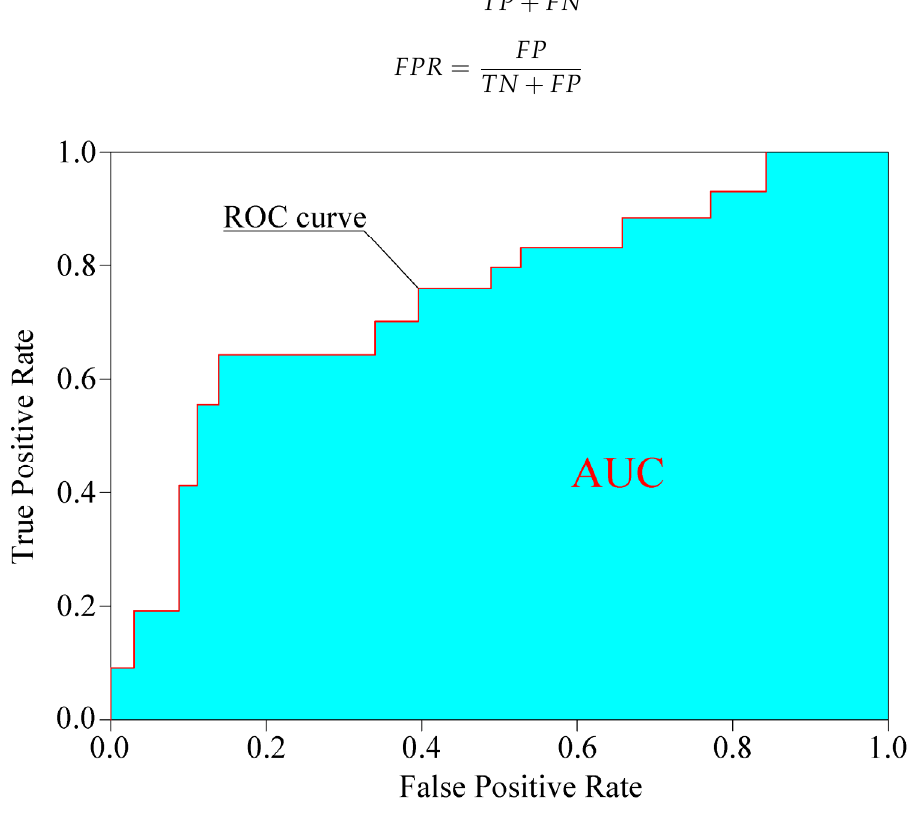
Figure 8. AUC and ROC diagram.